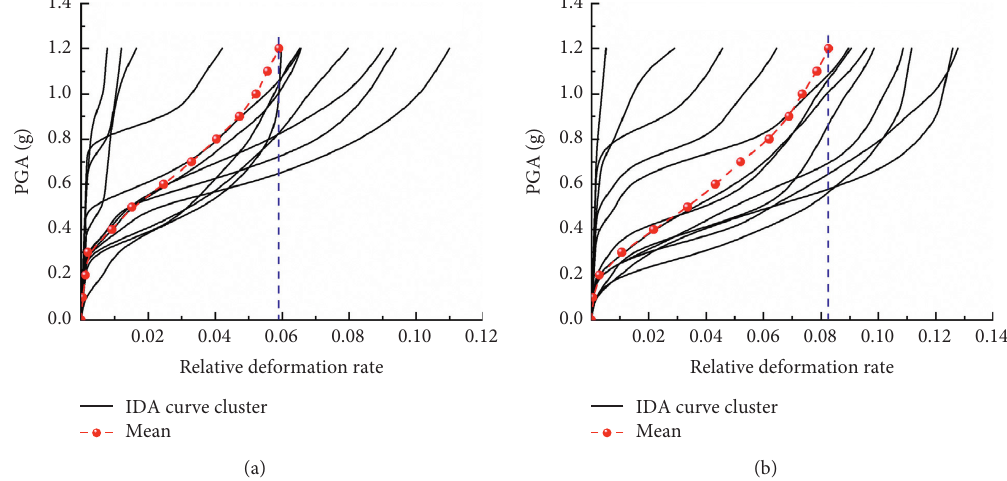
Figure 10: The IDA curve clusters under the action of different ground motions: (a) near-fault pulsed; (b)